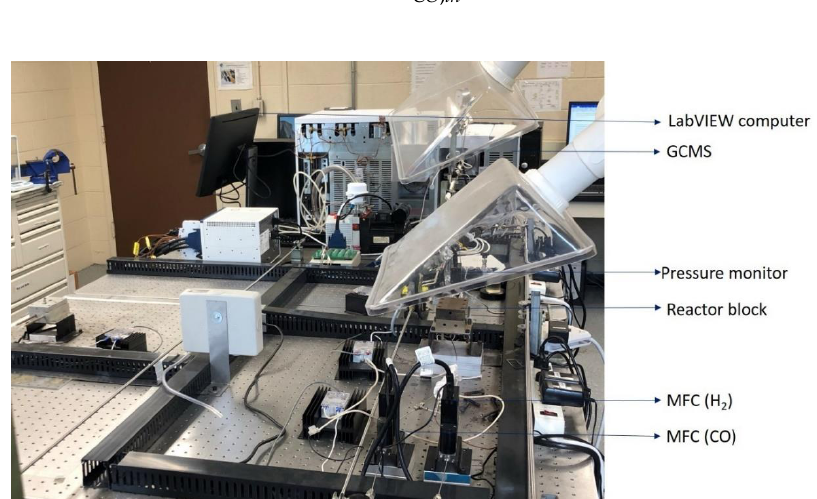
Figure 14. Experimental set-up for FT synthesis in a 3-D printed stainless steel microreactor.